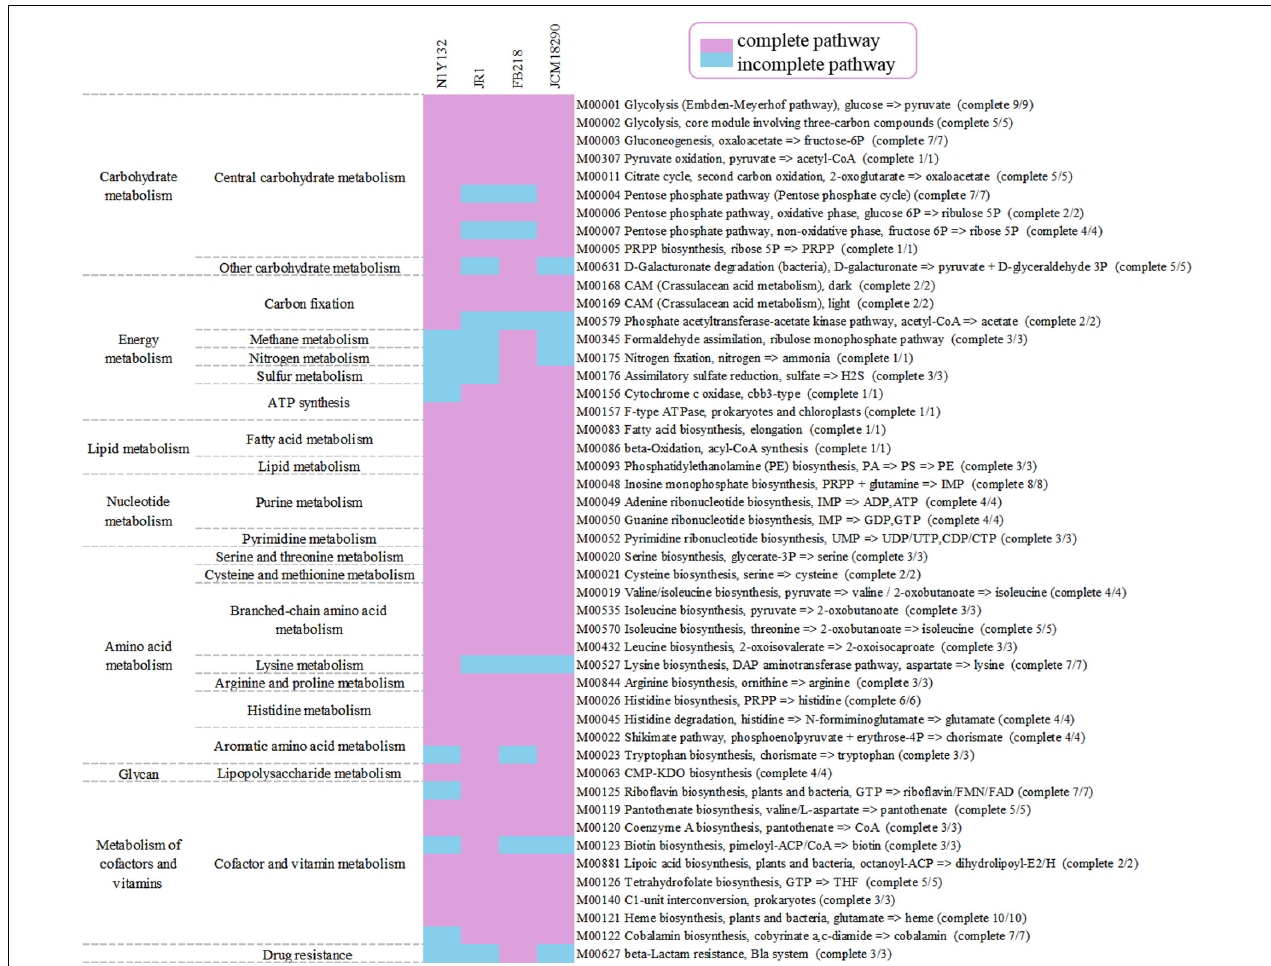
FIGURE 3 | Heat maps of complete and incomplete metabolic pathways in the genomes of strain N1Y132 T , C. sediminis JR1 T , C. linearis FB218 T , and C. mesophila JCM 18290 T based on KEGG database.